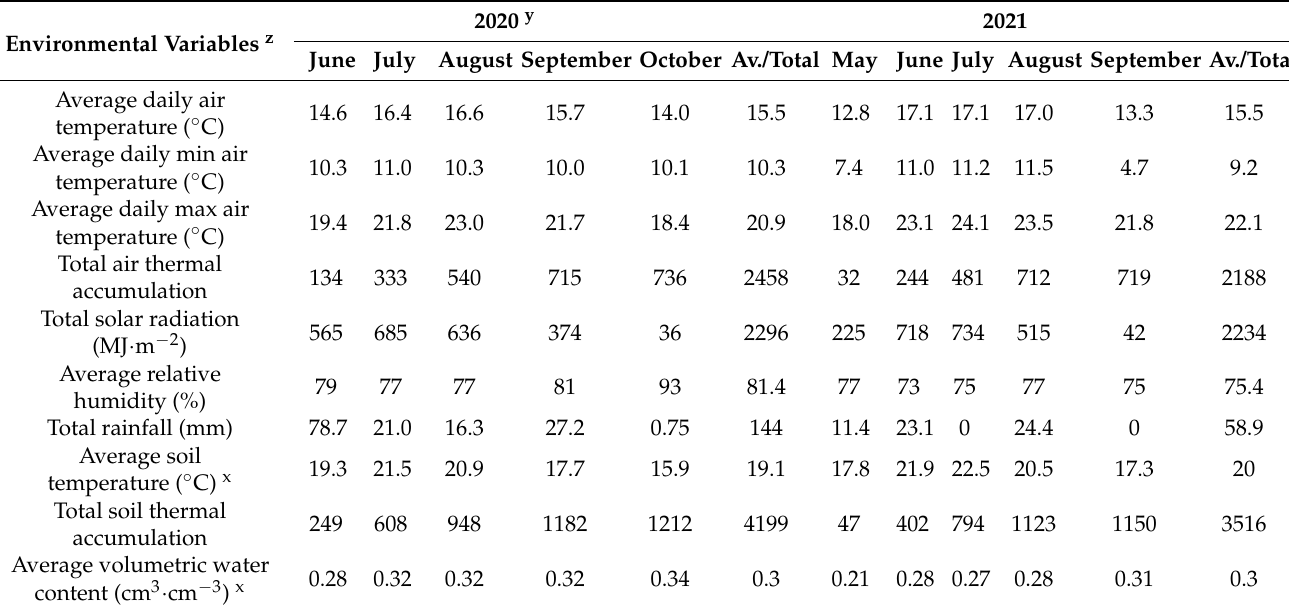
Table 2. Environmental and soil conditions during the growing season (1 June to 5 October 2020 and 20 May to 2 September 2021) at Mount Vernon, WA, USA, in 2020 and